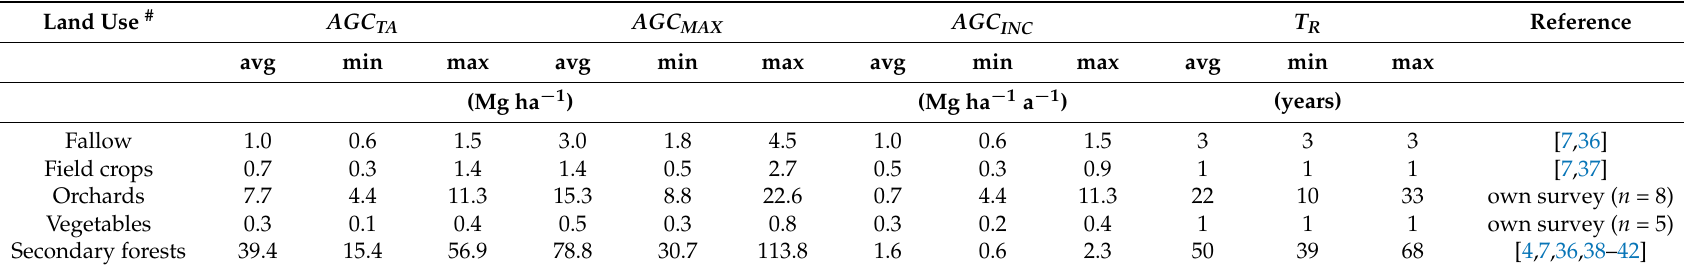
Table 3. Summary of land use type-specific input data (in Mg ha − 1 ) employed for carbon-stock accounting; ( AGC TA )—time-averaged above-ground-carbon per